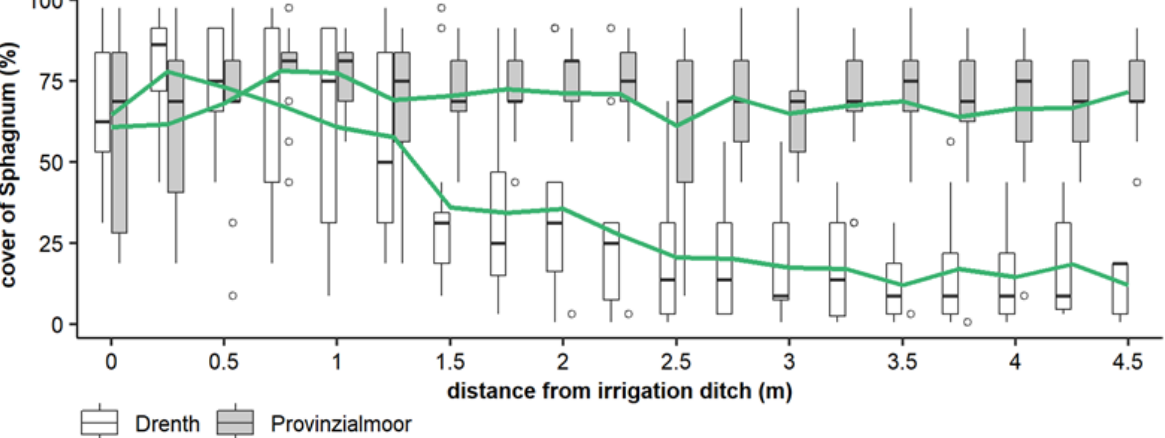
Figure 9. Dependence of Sphagnum cover (%) on the distance (m) of the sampling location to the nearest irrigation ditch at the study sites Drenth and Provinzialmoor (including an equal number of samples from both species ( S. palustre and S. papillosum ) and only data from sections where straw was used as protective cover). Boxplots are showing median (central thick lines), 25 % and 75 % quartile ranges around the median (box length) and outliers (circles); the green line connects the mean values; n=12 number of samples for each